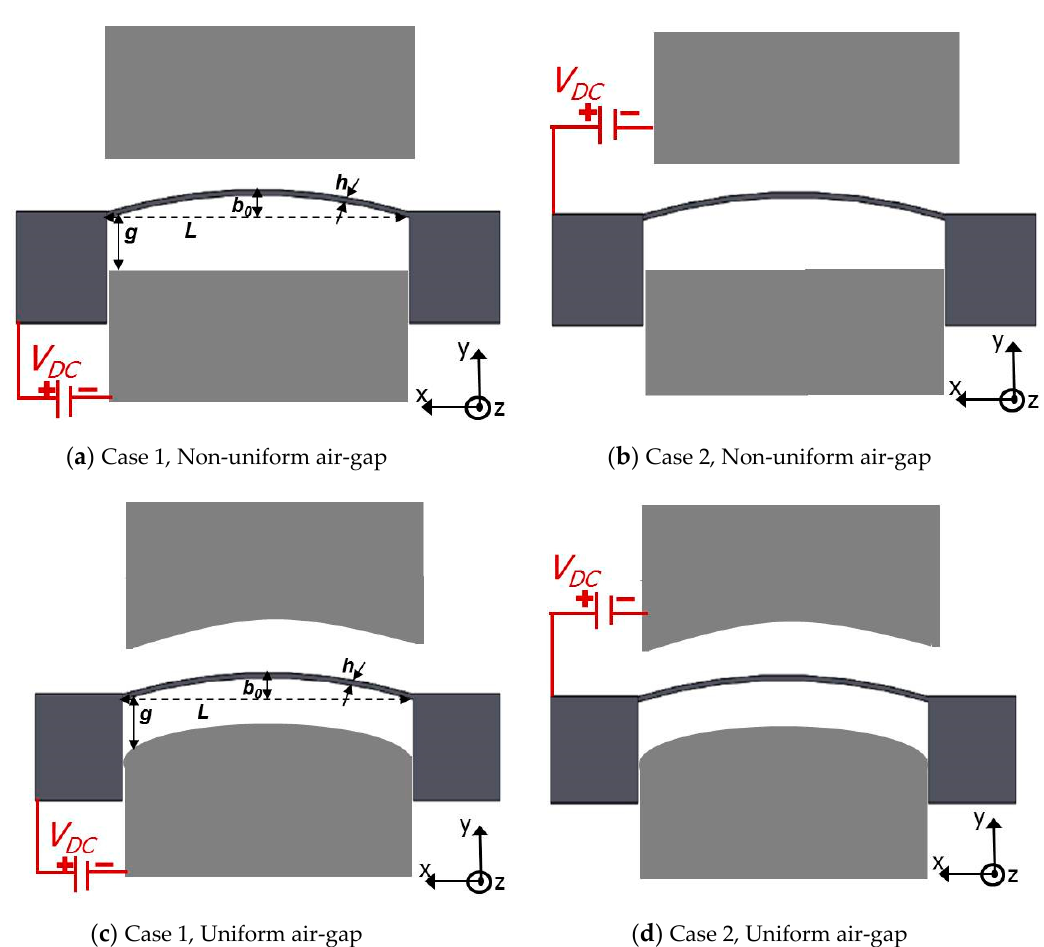
Figure 1. Schematics of electrostatically actuated in-plane COSINE-shaped resonators. ( a ) Case 1 and ( b ) Case 2: the micro-beams and the stationary electrodes are separated with non-uniform air-gap ( g ). ( c ) Case 1 and ( d ) Case 2: the micro-beams and the electrodes are separated with a uniform g .